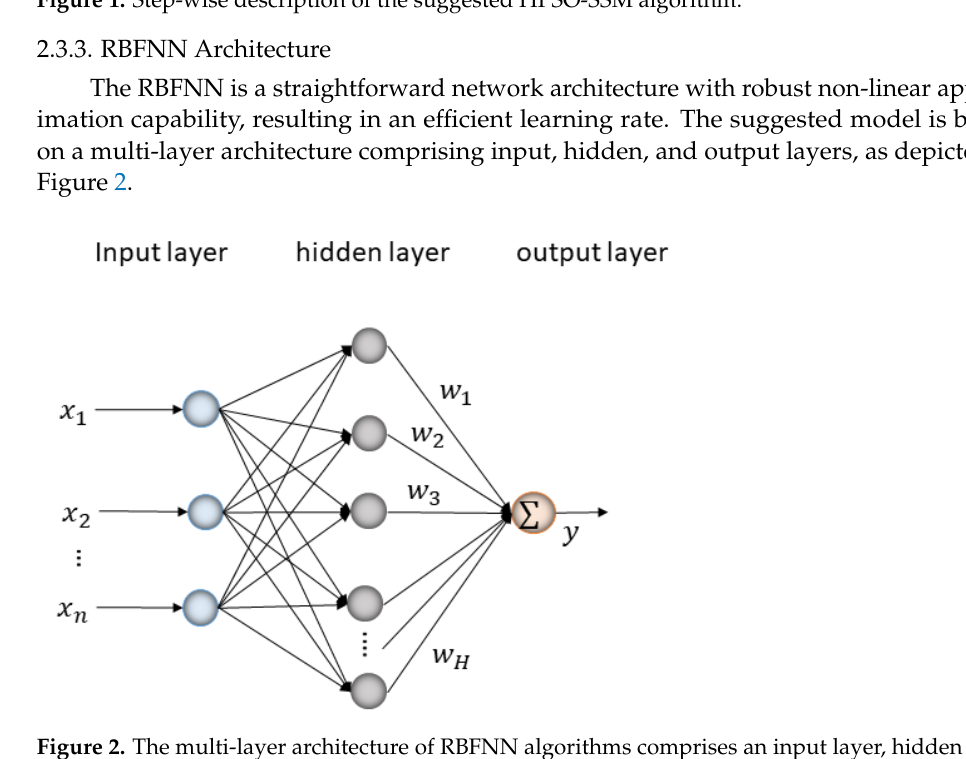
Figure 1. Step-wise description of the suggested HPSO-SSM algorithm.